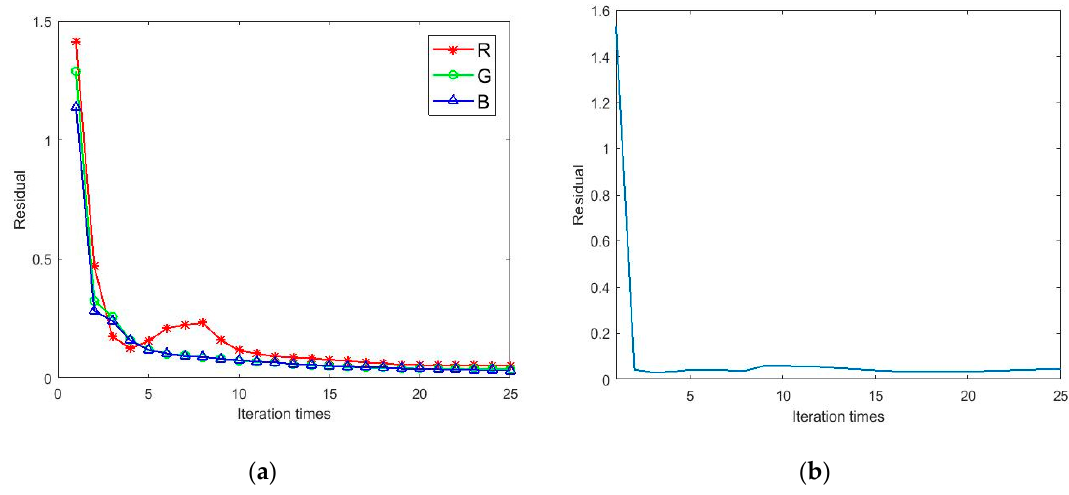
Figure 5. The convergence of the proposed method: ( a ) the convergence of image, and ( b ) the convergence of blurring kernel.